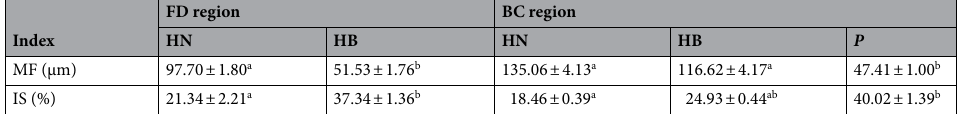
Table 1. Quantification by light microscopy of Feret’s diameter of muscle fiber (Feret’s MFD) and percentage of interstitial space (IS) of the FD and BC region. Data are presented as mean ± SD (n = 5). Twenty measurements were recorded per sample. Data with different superscript letters in one row of each muscle region represent a significant difference between flesh color phenotypes: HN High color-No banding fish, HB High color-Banded fish, P Pale fish, MF muscle fiber, IS interstitial spaces. Significant differences were determined by one-way ANOVA ( P ≤